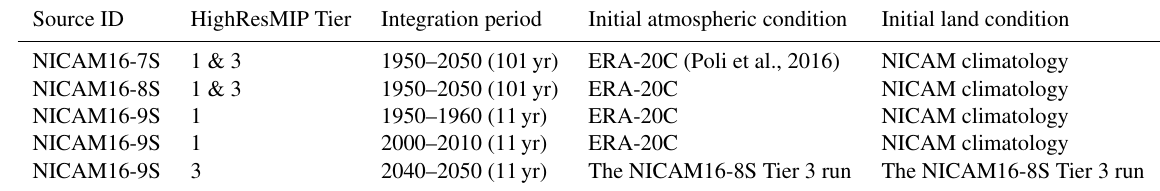
Table 1. List of HighResMIP simulations.